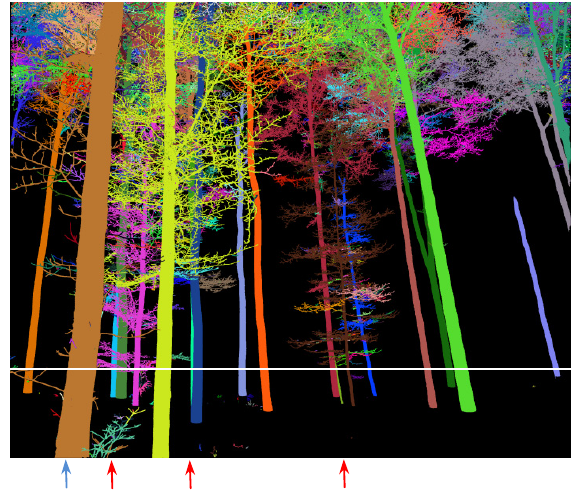
Figure 9. Segmented range image with image line (white horizontal line at y'=1655 px) and 3 partly hidden trees (detected during the image line analysis, red arrows). The blue arrow marks the stem which is missed in the tree detection with the 'validation algorithm' (see section 5.3).